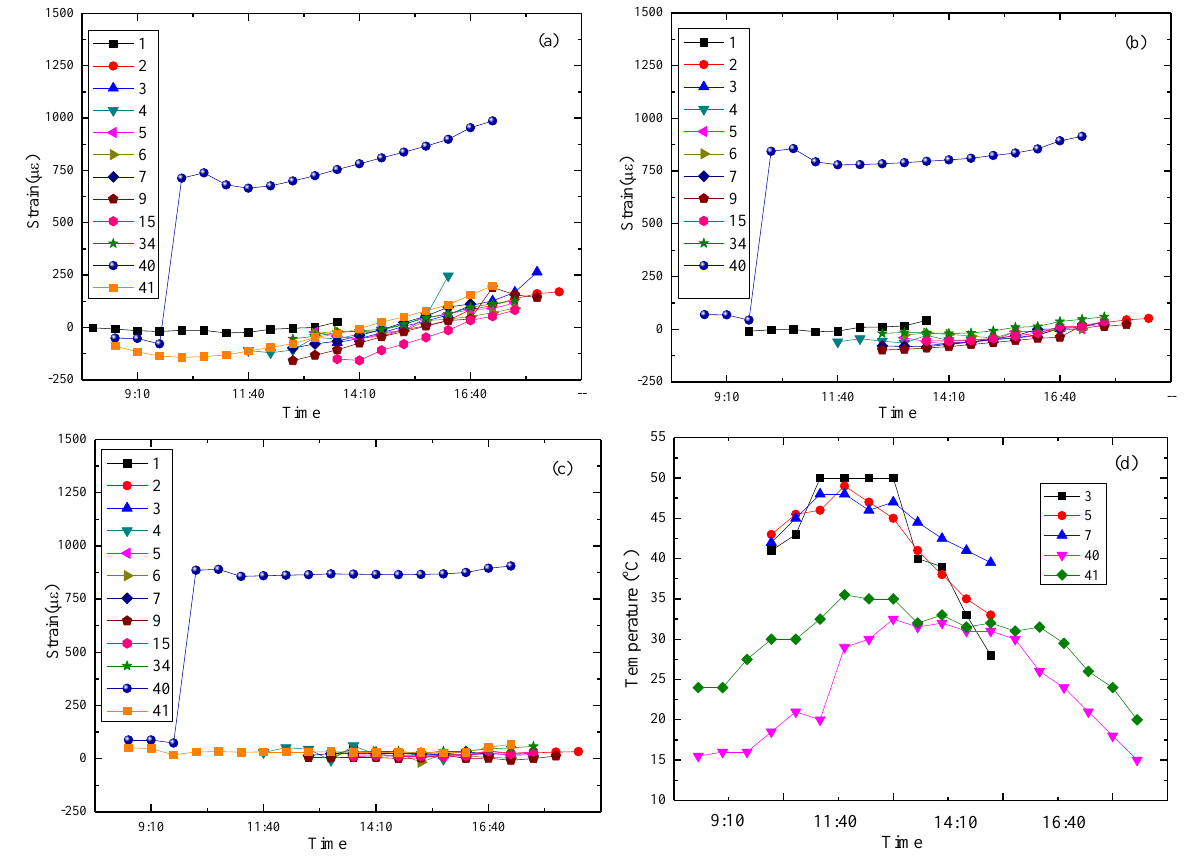
Figure 23. Strain detected by FBG sensors: ( a ) microstrain of the cement stabilized gravel layer by FBG-2; ( b ) microstrain of the gravel layer by FBG-3; ( c ) microstrain of the asphalt concrete layer by FBG-4; ( d ) ground temperature distribution on select